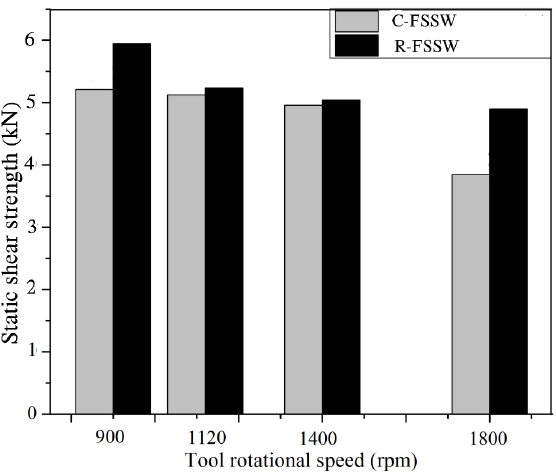
Figure 5. Static shear strength of FSSW joints under different rotational speeds.